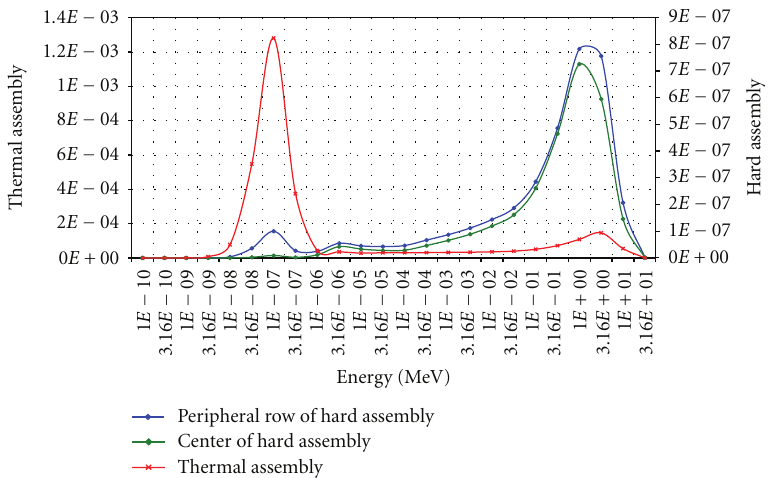
Figure 4: The relative neutron spectra in the thermal assembly, in the peripheral and the central rods of the hard assembly.